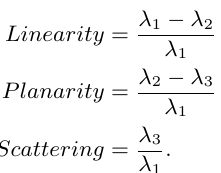
Figure 2. Means and standard deviations of the local descriptors in the Oakland dataset for the following classes: wires, poles, façades, roads, vegetation.